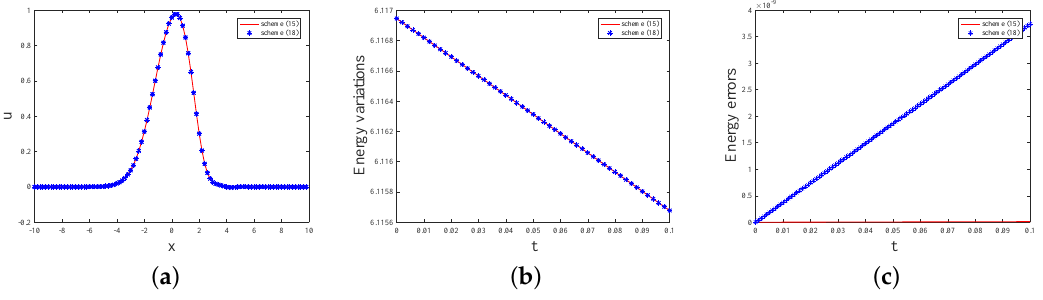
Figure 2. The waveforms ( a ), energy variationas ( b ) and energy errors ( c ) of the scheme (15) and the scheme (18).